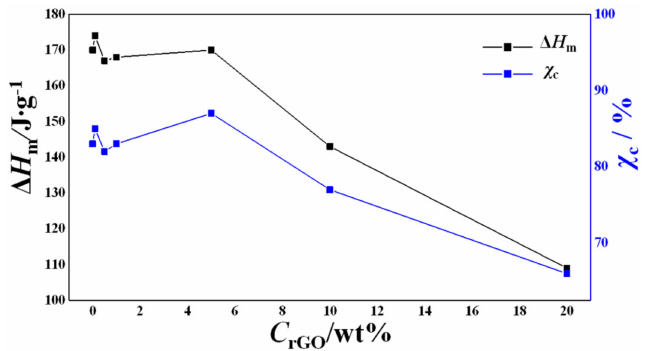
Figure 8. Dependence of enthalpy of fusion ( ∆ H m ) and weight fractional crystallinities ( χ c ) on rGO